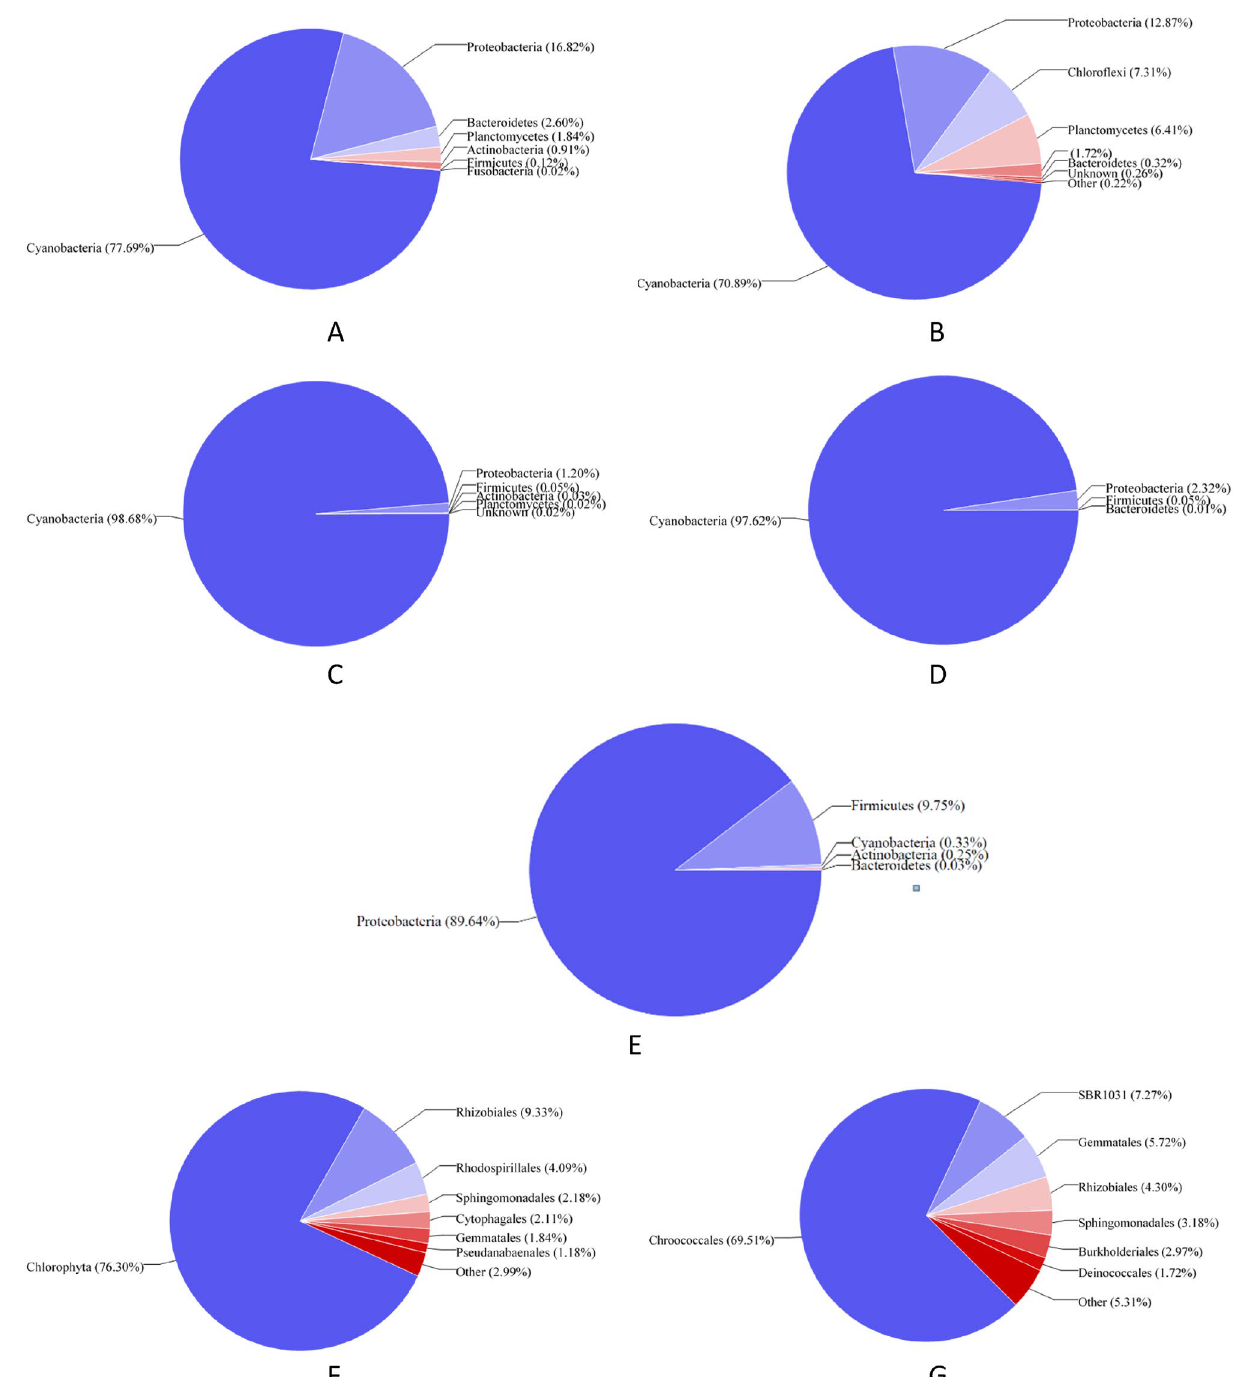
Figure 4. Pie charts showing the relative proportion of phyla: ( A ) (GFF1), ( B ) (GFF2), ( C ) (P1), ( D ) (P2), and ( E ) (P3); and order: ( F ) (GFF1) and G (GFF2) amplified by the primers set used in the present